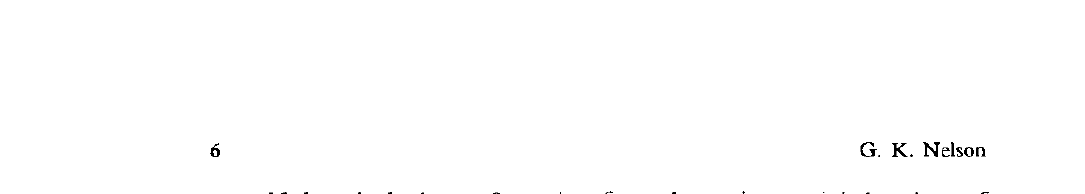
Fig. 1. Placement of EEG Elec- trodes: Electrode positions and names are in accordance with the recommendations of the Interna- tional Federation of Societies for Electroencephalography and Clinical Neurophysiology. Recor- dings may be bipolar (connecting electrodes in serial chains, e.g. FP1-F3, F 3 - C 3) C 3 - P 3) P 3 -OI, etc.) or unipolar, referring each cortical electrode to a "neutral" or reference electrode. Unless otherwise stated, all EEG figures in this paper show bipolar recor-